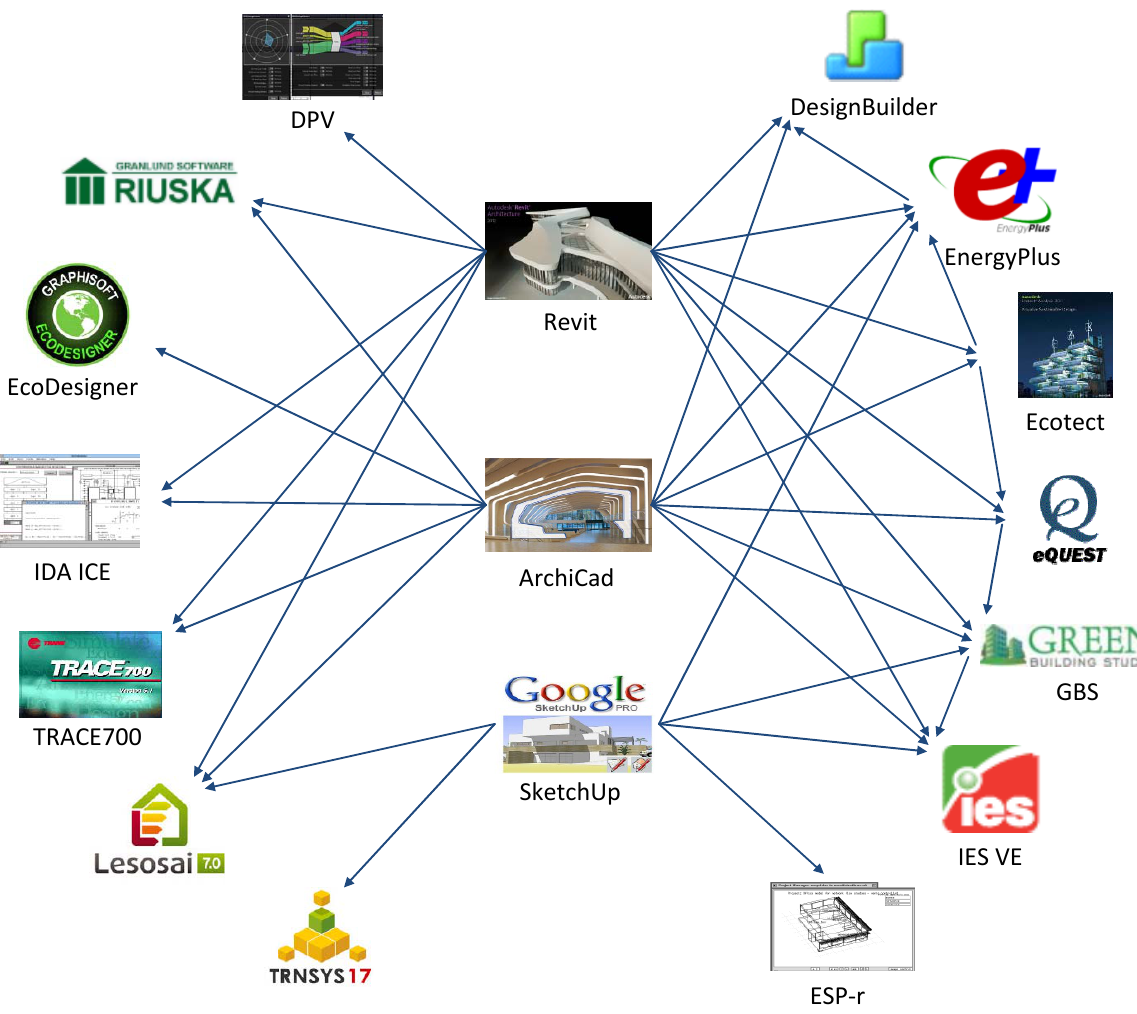
Figure 5. Summary of data exchange between modeling tools and thermal simulation tools. The linkages include those as interface, add-on or plug-in. The data exchange is conducted in various formats, primarily by IFC and